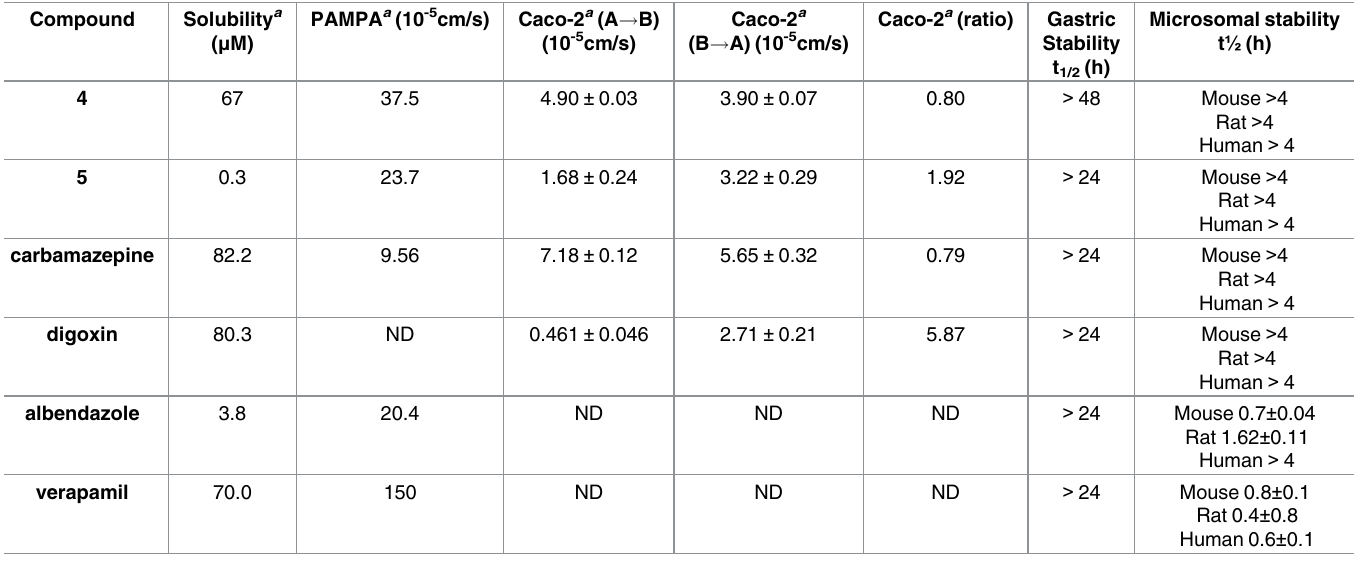
Table 1. In vitro ADME for compounds 4 and 5 and drug controls.